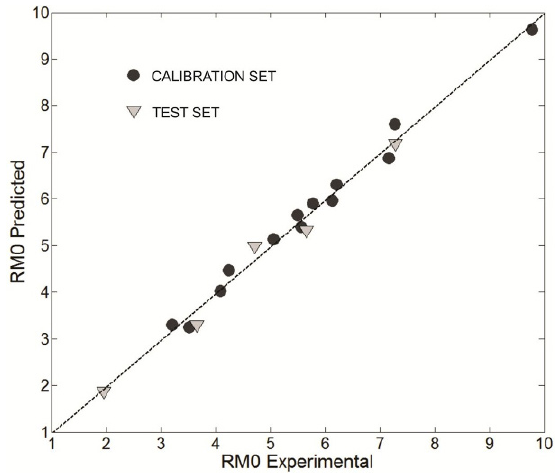
0 values according to MLR models. M